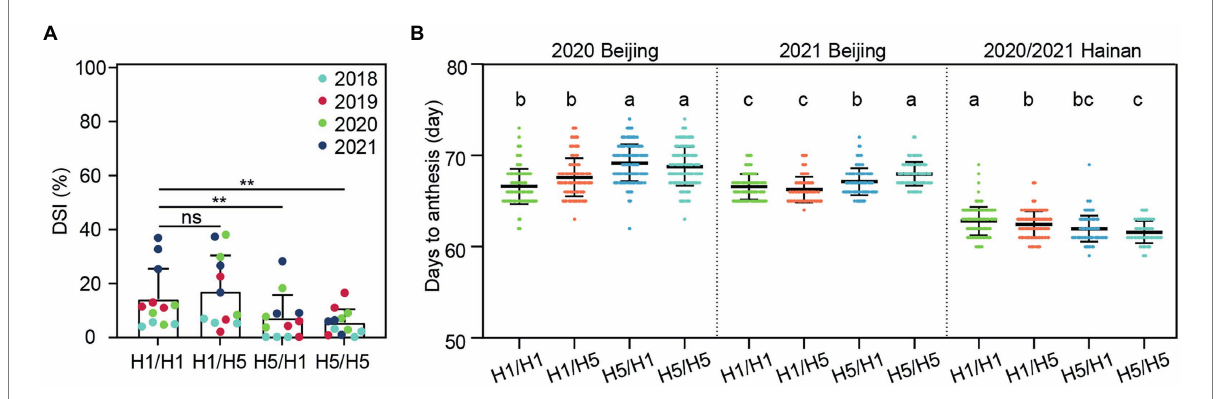
FIGURE 3 Evaluation of DSI and flowering time of four hybrids. In 2018–2021, the DSI (A) was investigated after artificial inoculated, each spot represents one replication of field trial (two-tailed paired Student’s t-test, ** p < 0.01, ns, not signifcant). The flowering time (B) of four hybrids was investigated in 2020–2021 Beijing and 2020/2021 Hainan, which represents long-day conditions and short-day conditions, respectively. H1/H1, H1/H5, H5/H1, and H5/H5 are genotypes of four hybrids representing 83B28 H1 × A5302 H1 , 83B28 H1 × A5302 H5 , 83B28 H5 × A5302 H1 , and 83B28 H5 × A5302 H5 , respectively. Values are mean ± standard deviation (s.d.). Different letters indicate significant differences among hybrids ( p < 0.05, one-way ANOVA, Tamhane test).